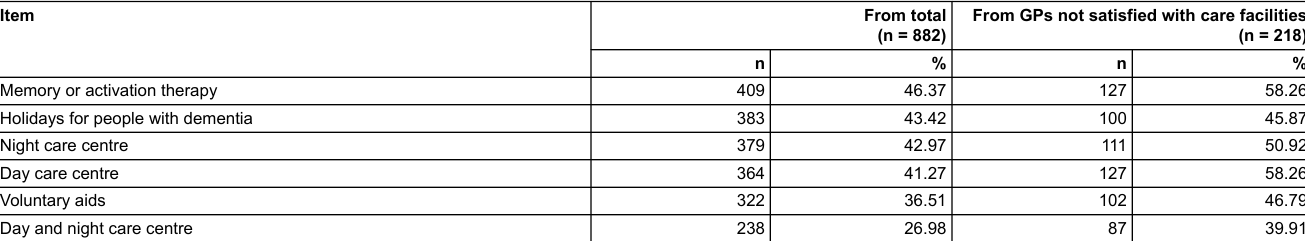
Table S5: Most required care facilities for patients with cognitive impairment in the catchment